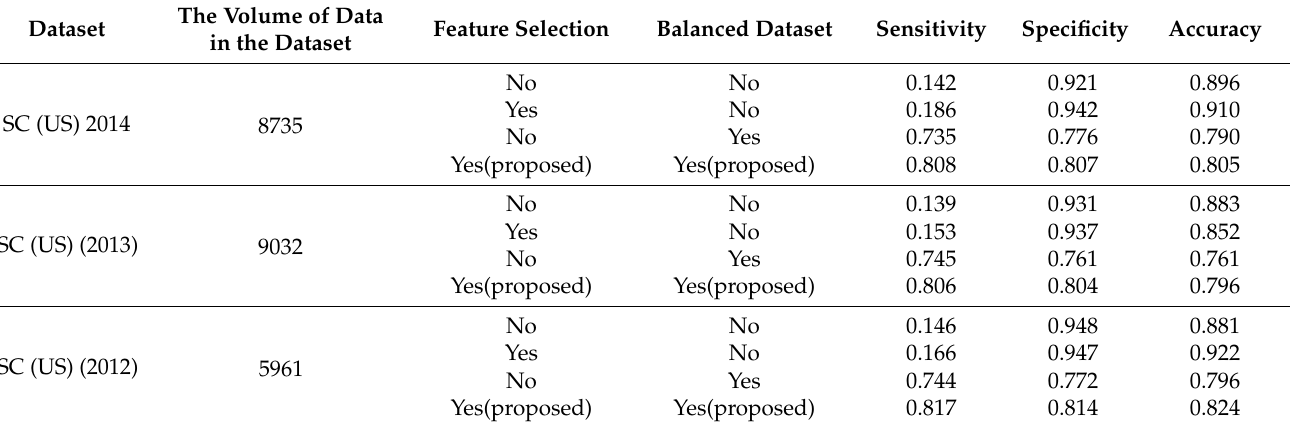
Table 16. The external evaluation of the proposed